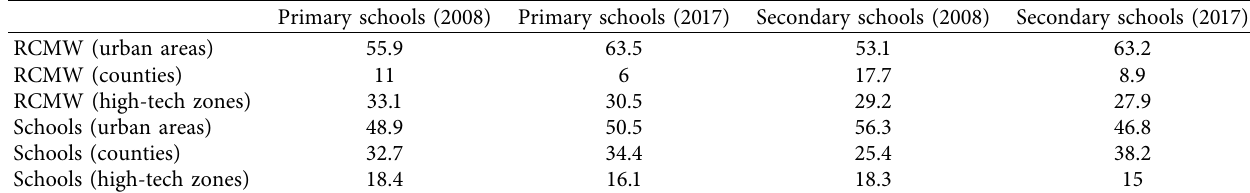
Figure 7: Concentration ratio of primary and secondary schools’ RCMW and their schools in Liaoning Province in 2008 and 2017. Table 4: Concentration ratio of primary and secondary schools’ RCMW and schools with RCMW in main urban areas, counties, and high- tech zones in Liaoning Province in 2008 and